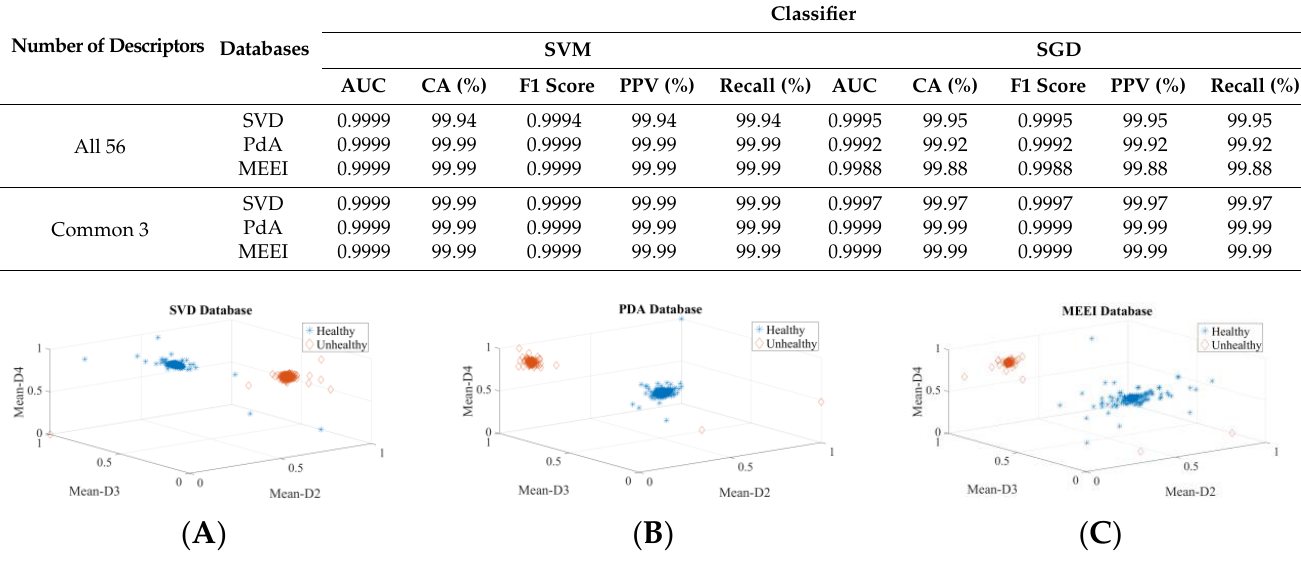
Figure 11. Three-dimensional scatter plots for detection process: ( A ) Three-dimensional scatter plot of SVD for detection process, ( B ) Three-dimensional scatter plot of PdA for detection process, ( C ) Three-dimensional scatter plot of MEEI for detection